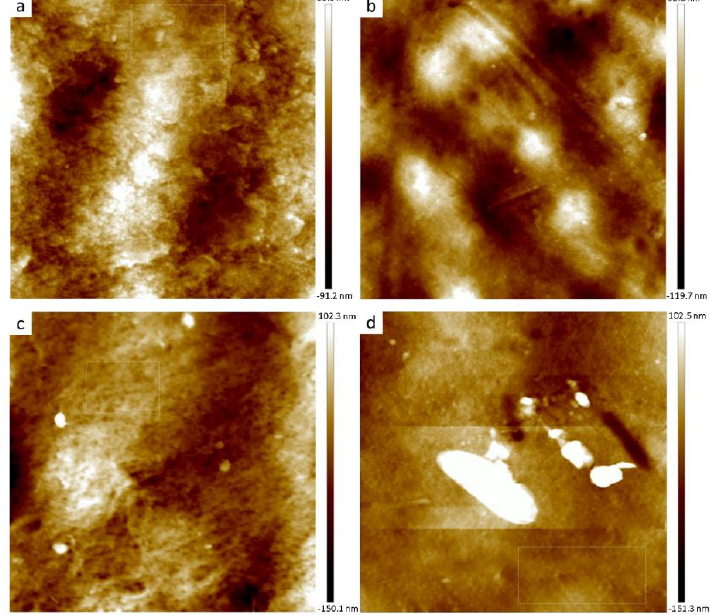
Figure 2. Atomic force microscopy (AFM) surface topography of ( a ) GO-0 wt% ( b ) GO S -0.2 wt% ( c ) GO H -0.2 wt% and ( d ) GO T -0.1 wt% membrane taken at 10 × 10 µ m scan area.